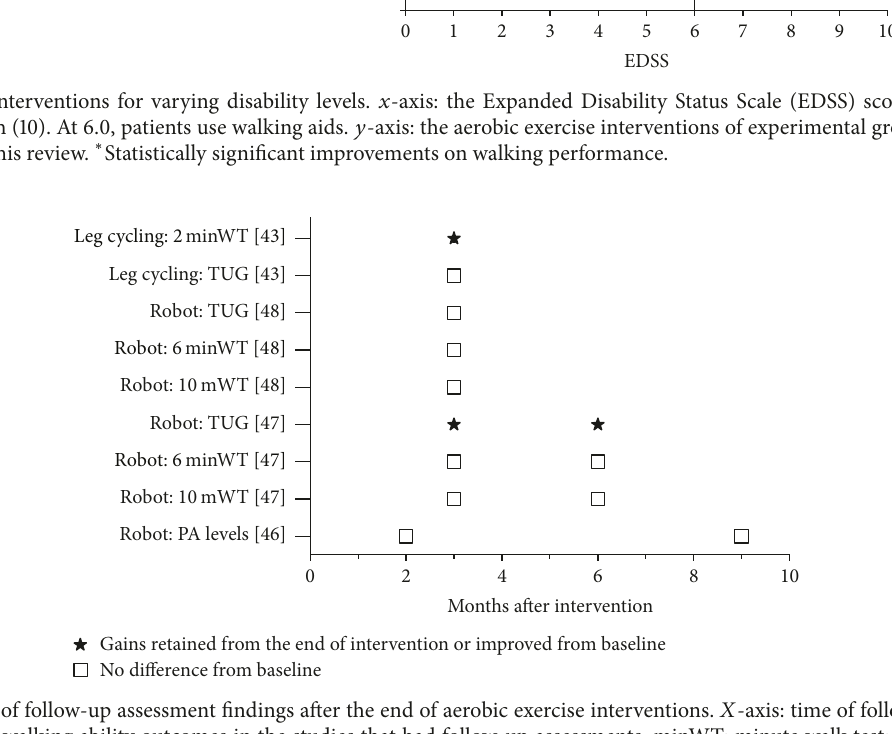
Figure 3: Summary of follow-up assessment findings after the end of aerobic exercise interventions. 𝑋 -axis: time of follow-up assessments (in months). 𝑌 -axis: walking ability outcomes in the studies that had follow-up assessments. minWT: minute walk test; mWT: meter